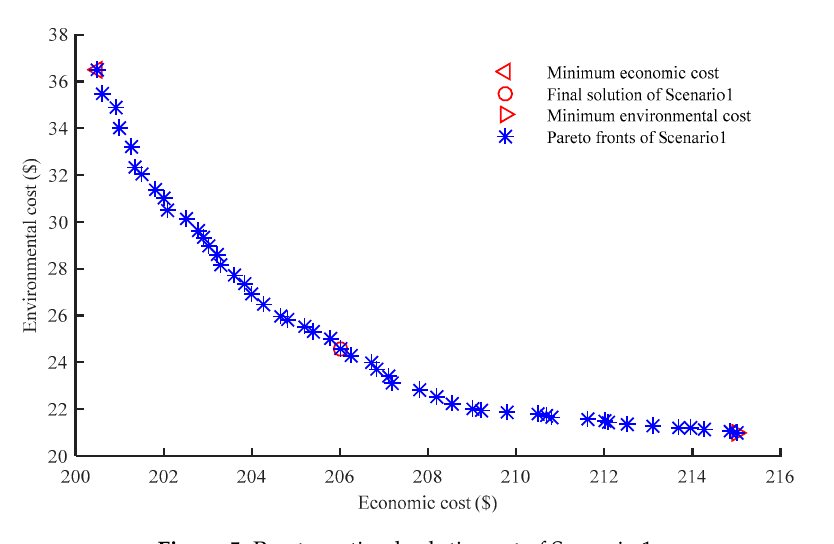
Figure 5. Pareto ‐ optimal solution set of Scenario 1. Figure 5. Pareto-optimal solution set of Scenario Table 6. Costs of three dispatching results.